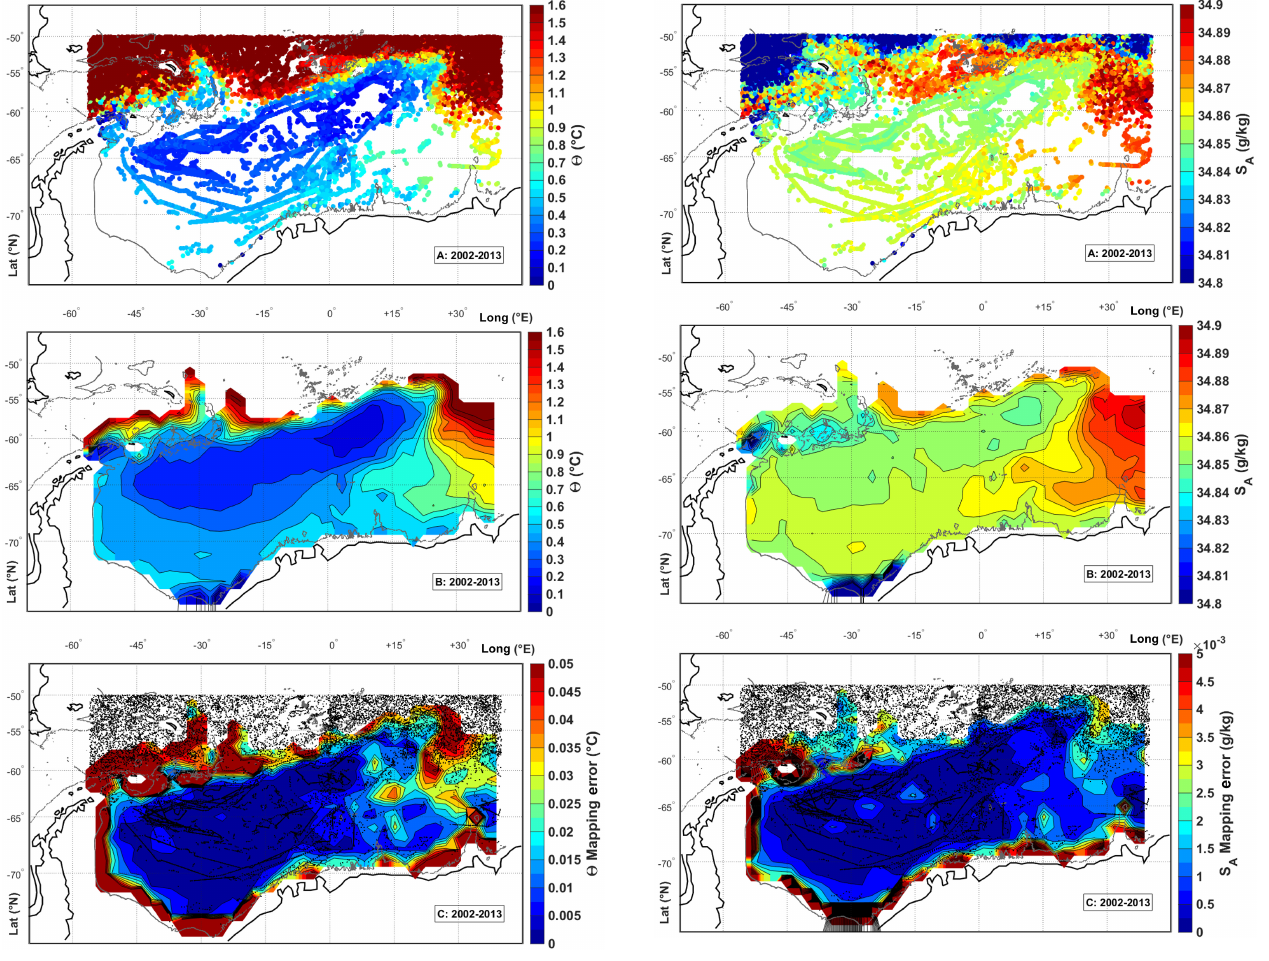
Figure 21. Conservative temperature ( ◦ C) at 800dbar for the entire time period, where panel (a) shows the original float data, panel (b) shows the objectively mapped field and panel (c) shows the mapping error for the mapped field (profile locations are marked as black dots). The grey contour shows the 2000m isobath.